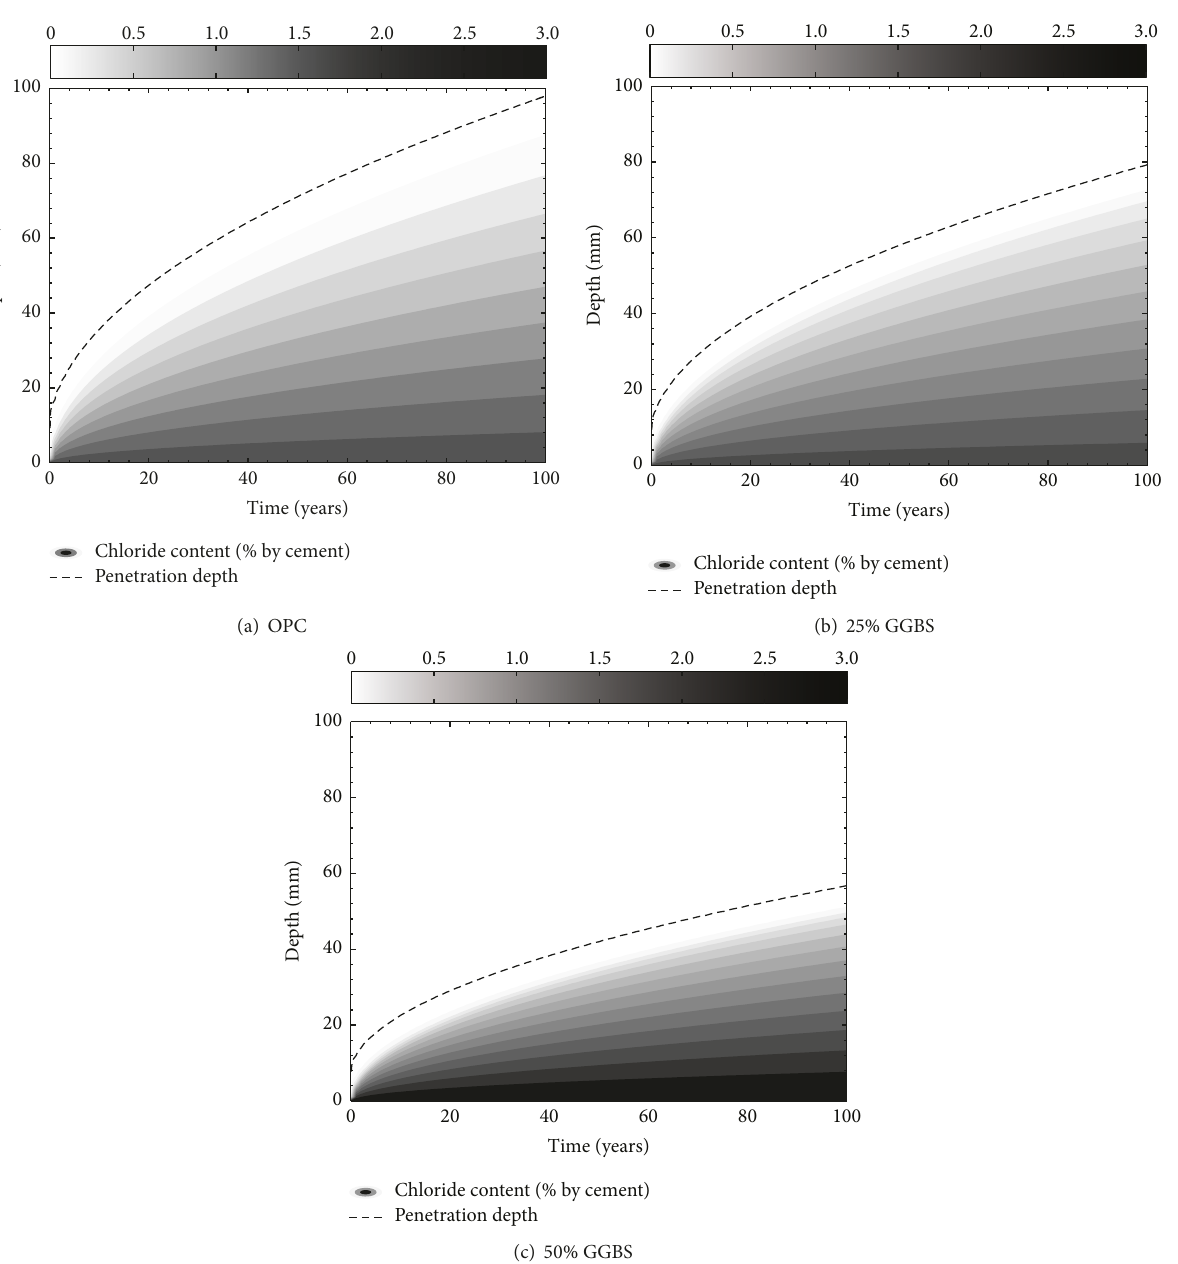
Figure 4: Contour plots of total chloride contents with variation of depth and